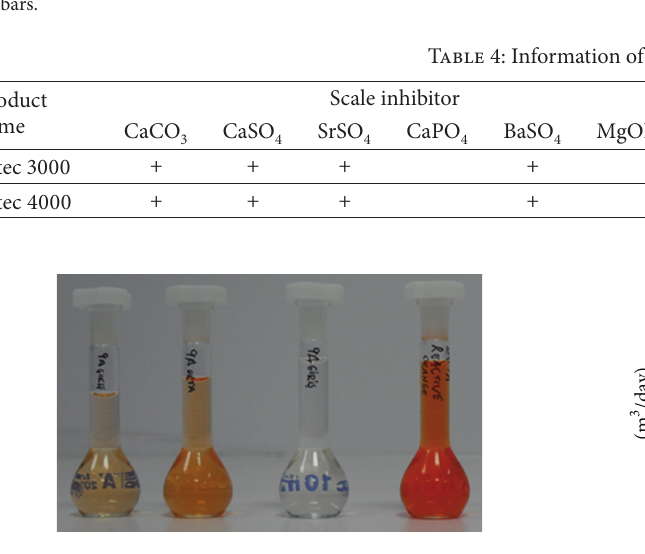
Figure 7: Feed dye solutions (right) and permeates collected using membranes taken from three different parts from membrane.